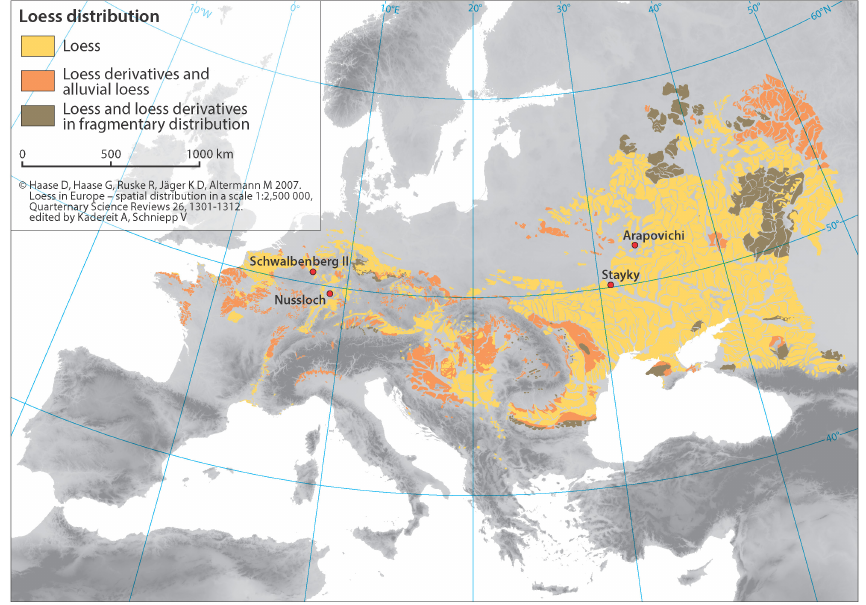
Fig. 1. Location of the well-developed loess sections Nussloch (key section for western Europe), Schwalbenberg II, Stayky (key section for eastern Europe) and Arapovichi within the European loess belt (map based on Haase et al.,